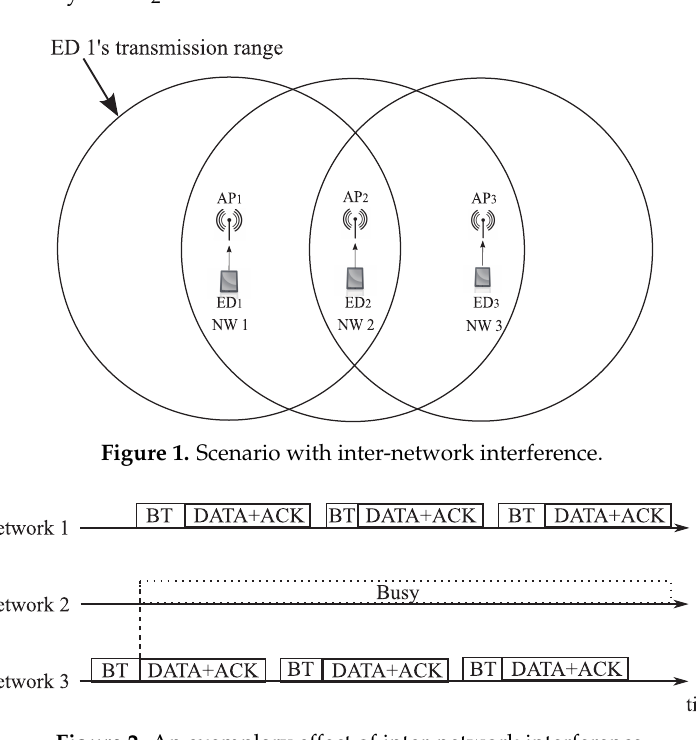
Figure 2. An exemplary effect of inter-network